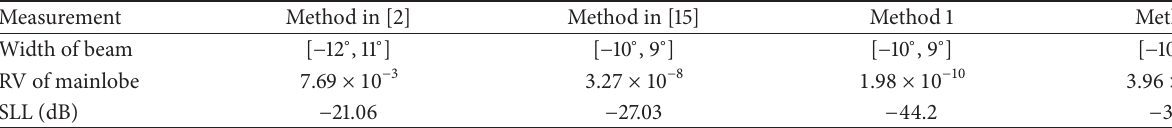
Table 1: Evaluation of four methods.